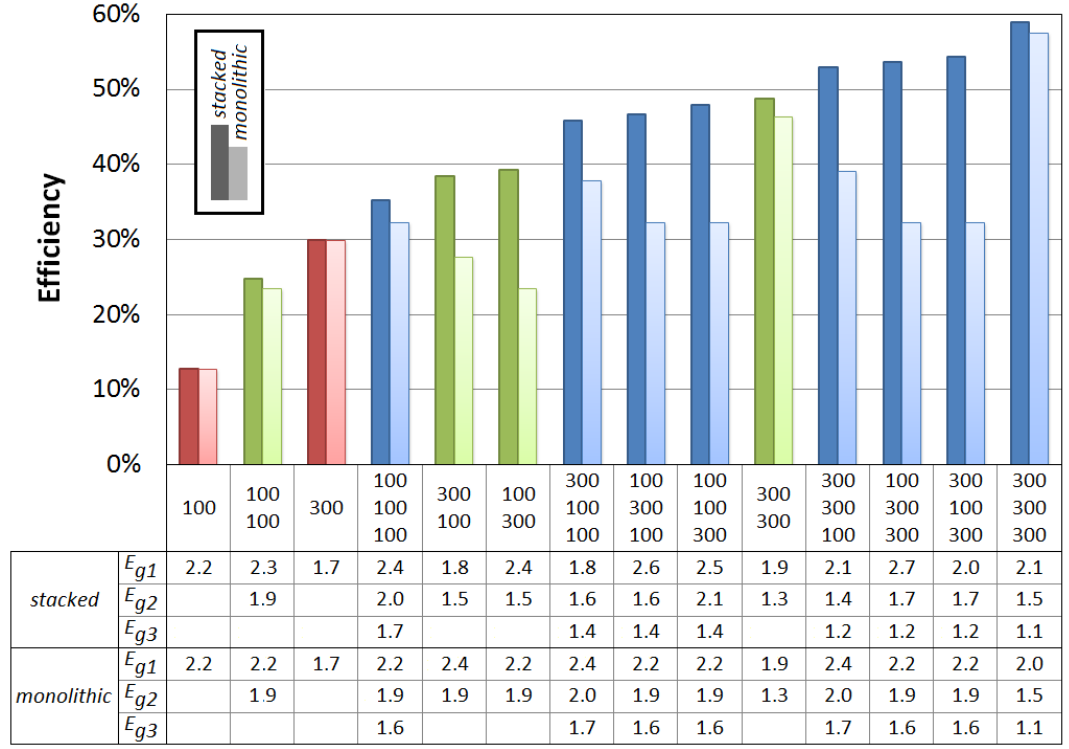
Figure 12. The maximum efficiency in the ideal scenario for an organic stacked and monolithic solar cell as a function of the absorption windows of the subcells. The label “300 100 100” for example indicates a triple-junction whose first subcell has an absorption window of 300 nm and whose second and third subcell have an absorption window of 100 nm. As comparison, we also add the single-junctions (in red) and tandem cells (in green). The optimal bandgaps of the subcells in each configuration are given in